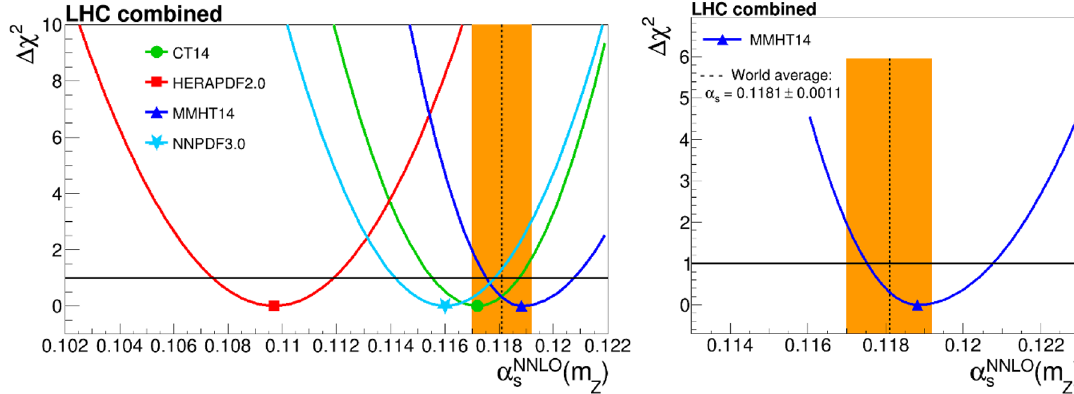
Figure 5 . Final (cid:11) s ( m Z ) values extracted from the analysis of the electroweak boson inclusive cross sections at the LHC using the CT14, HERAPDF2.0, MMHT14, and NNPDF3.0 PDF sets (left), and (cid:11) s ( m Z ) extraction from the MMHT14 PDF alone (right), compared to the current world average (vertical orange